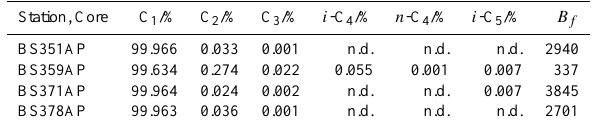
Table 4. Gas Hydrate Compositions from Batumi Seep Cores (BS350G: n =4; BS352G: n =1) and Pechori Mound